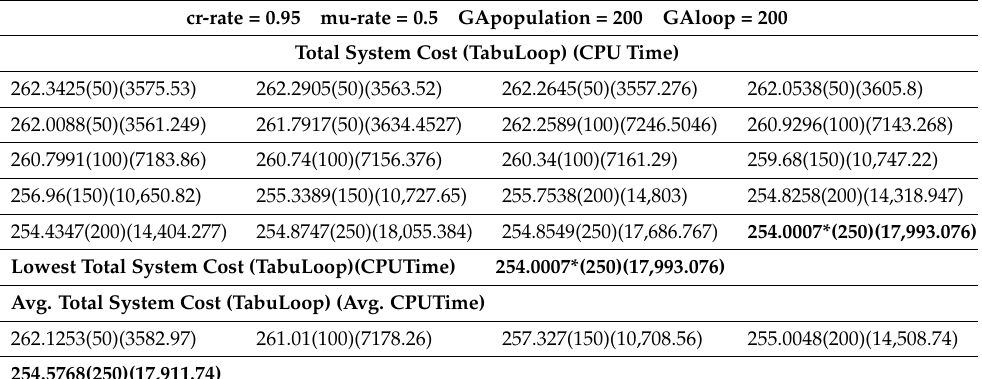
Table 27. The total system costs of 20 simulation runs obtained by TA–MGA for the n -stage q/2 -out- of- q system.